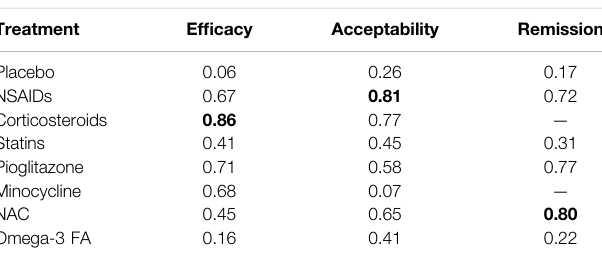
TABLE 5 | SUCRA value for treatment ranking.